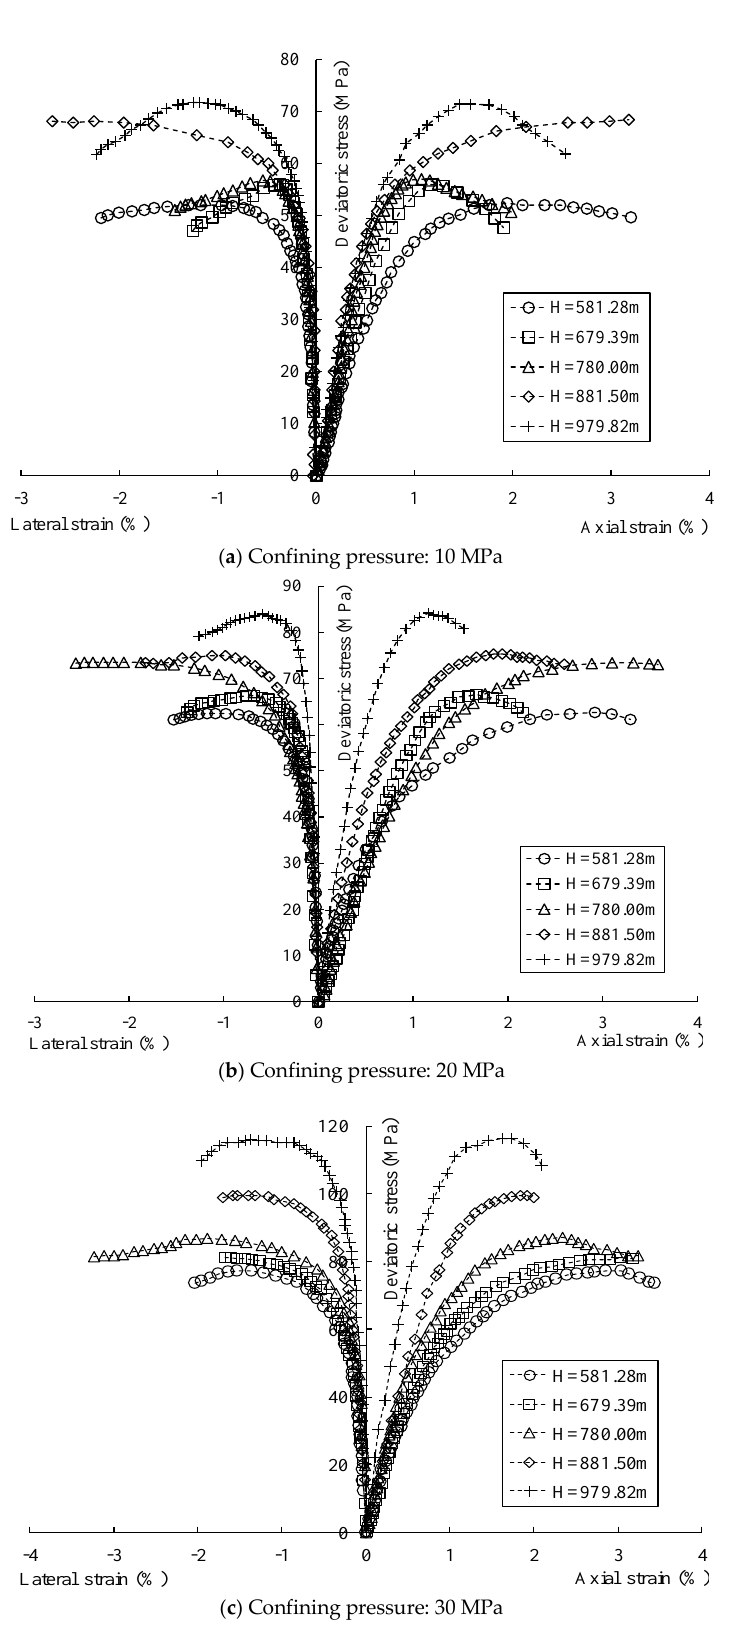
Figure 3. Stress-strain curves of clastic sandstone at different burial depths in triaxial compression tests.